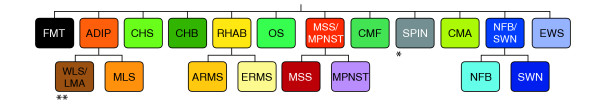
Schematic of two-step model. In order to successfully classify the sarcoma with the minimum of errors a two-step approach was used. A mixture of single sarcoma and composite classes were used for prediction in step one. Then, in step two, composite classes were separated into their constituent tumors. * The SPIN (spindle-like) group comprising PMS, LMS, and DCS could not be separated by our model. ** The WLS and LMA could not be separated by our model but were distinct from MLS. ADIP, adipocytic tumors; RHAB, rhabdomyosarcoma.